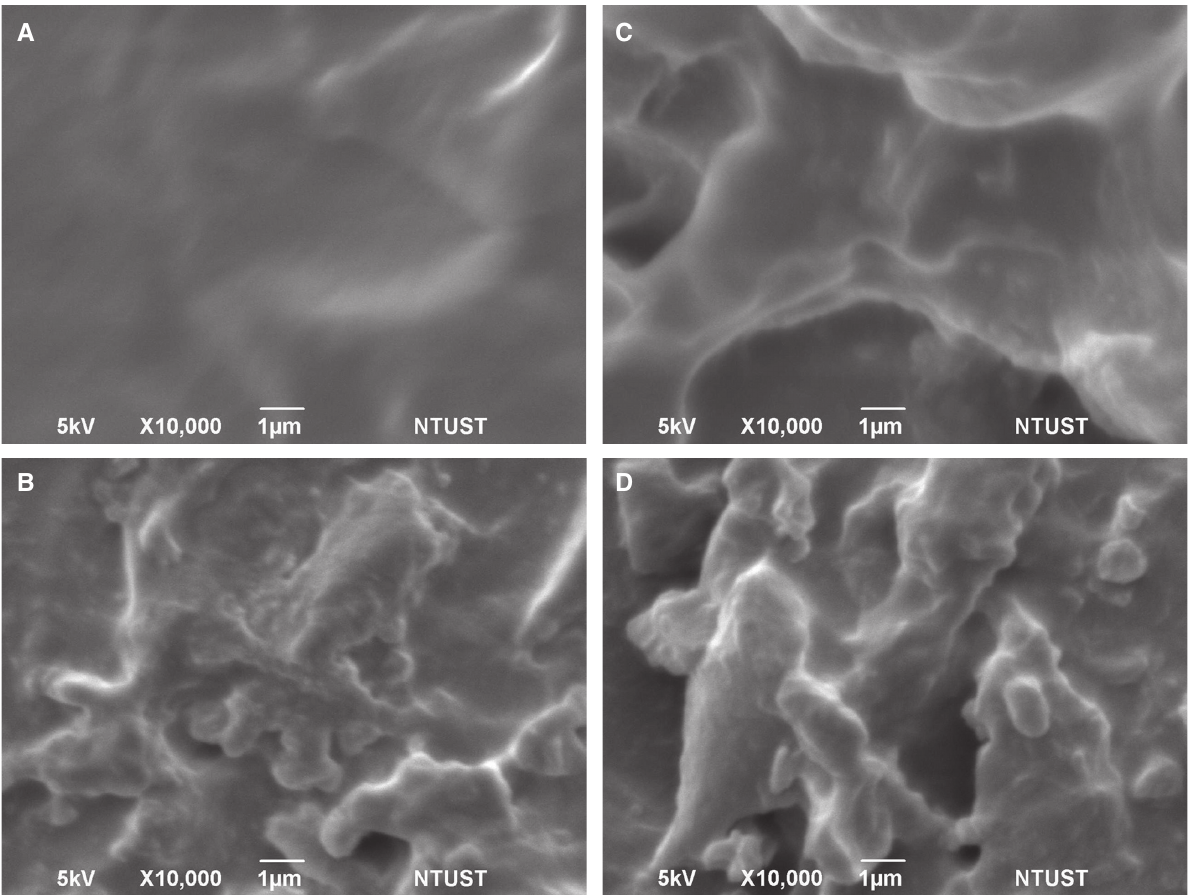
Figure 3 SEM images of the sample M 3500X (A) without any addition, (B) 2 phr clay-no dispersant, (C) 2 phr clay-1 phr dispersant, and (D) 2 phr clay-10 phr